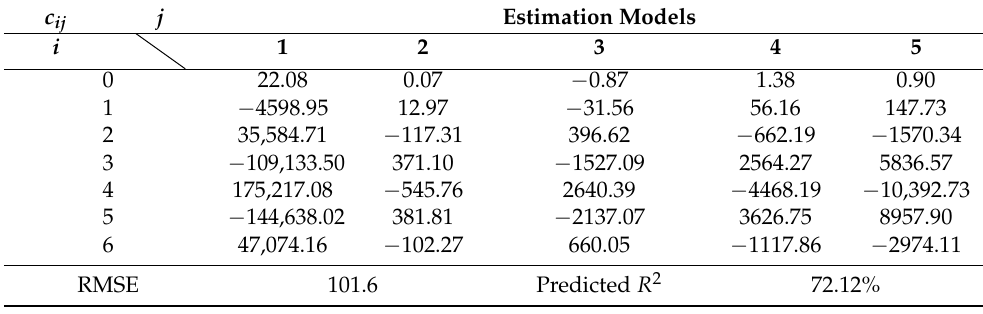
Table 6. Estimated coefficients of the prediction model for σ TR and performance measures (center). c ij